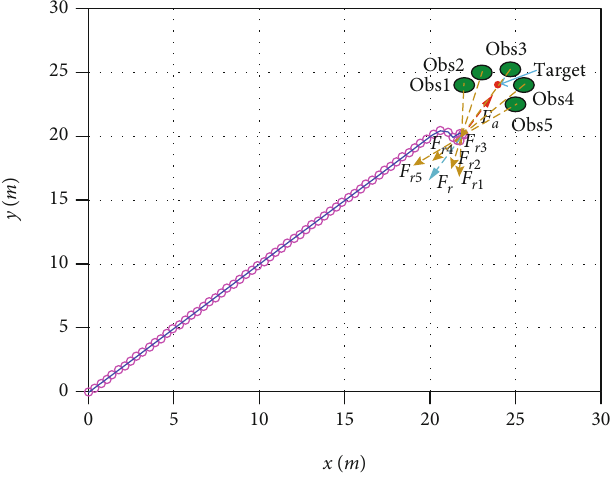
Figure 3: Scenario 1: the unreachable goal of TAPF.